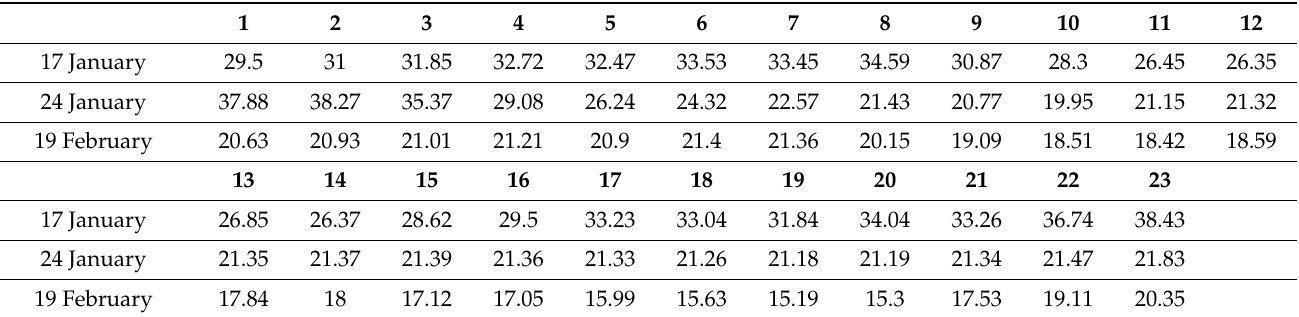
Table 6. Summary of input ambient air temperature data to Envi-met software derived from the fixed weather station in Bondi